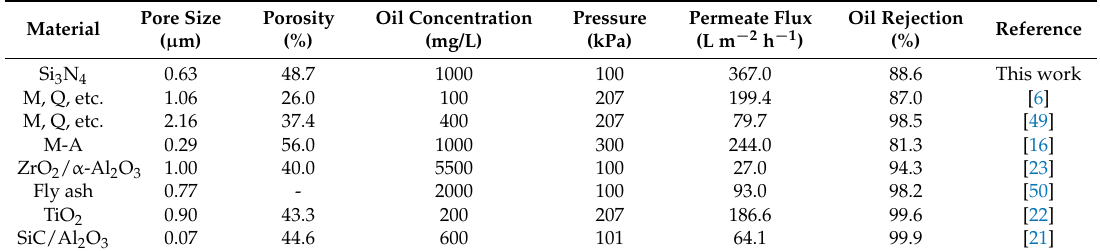
Table 3. Comparison of the permeate flux and oil rejection in the present work with other membranes reported in the literature for the separation of an oil-in-water